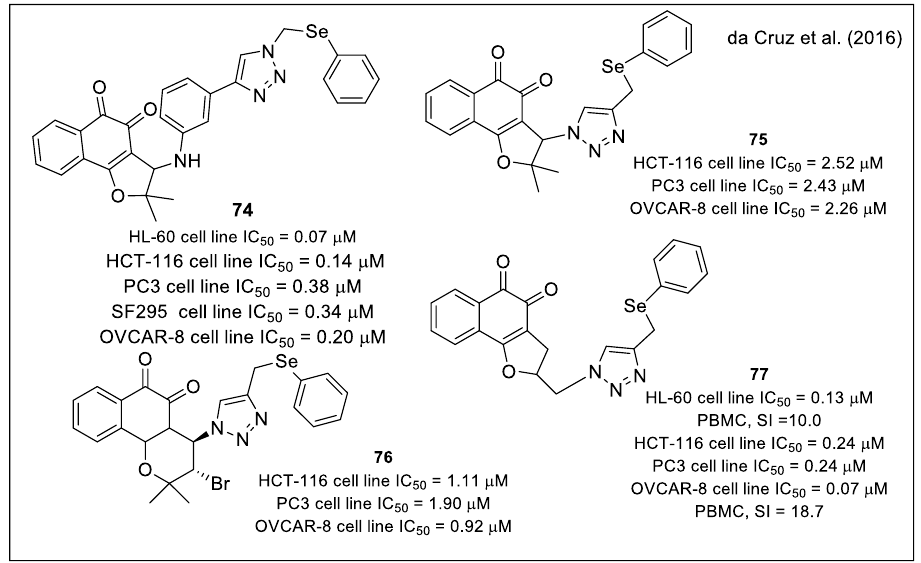
Figure 27. Molecular structures and cytotoxic data of the most active Se- containing compounds as reported by da Cruz et al. [68]. reported by da Cruz et al.